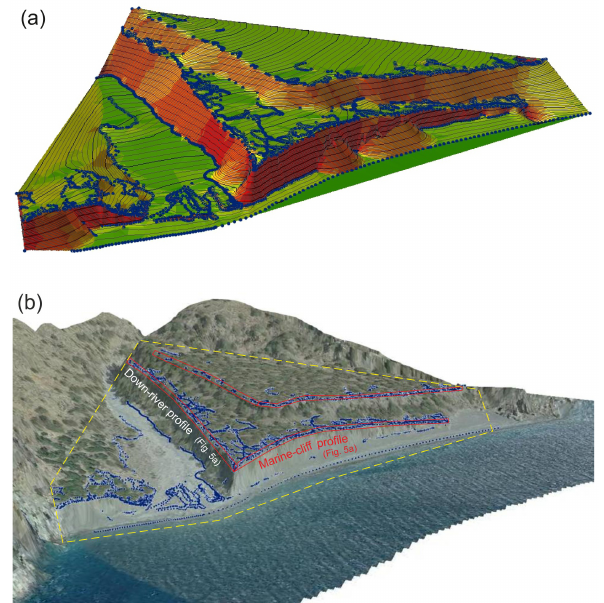
Figure 4. (a) Digital elevation model of the study area at Domata as viewed obliquely from the southwest. The model is derived by using the nearest-neighbour algorithm along with the GPS mea- surements marked and colour coded by 10m elevation bands. Note the upper- and lower-fan surfaces, each incised following surface abandonment and each trimmed by marginal marine processes. (b) Digital elevation model with National Greek Cadastre Agency or- thophoto draped onto it, along with the GPS measurements. The yellow polygon depicts the area illustrated in the DEM of panel (a) . Red polygons indicate the localities of the profiles presented in Fig.